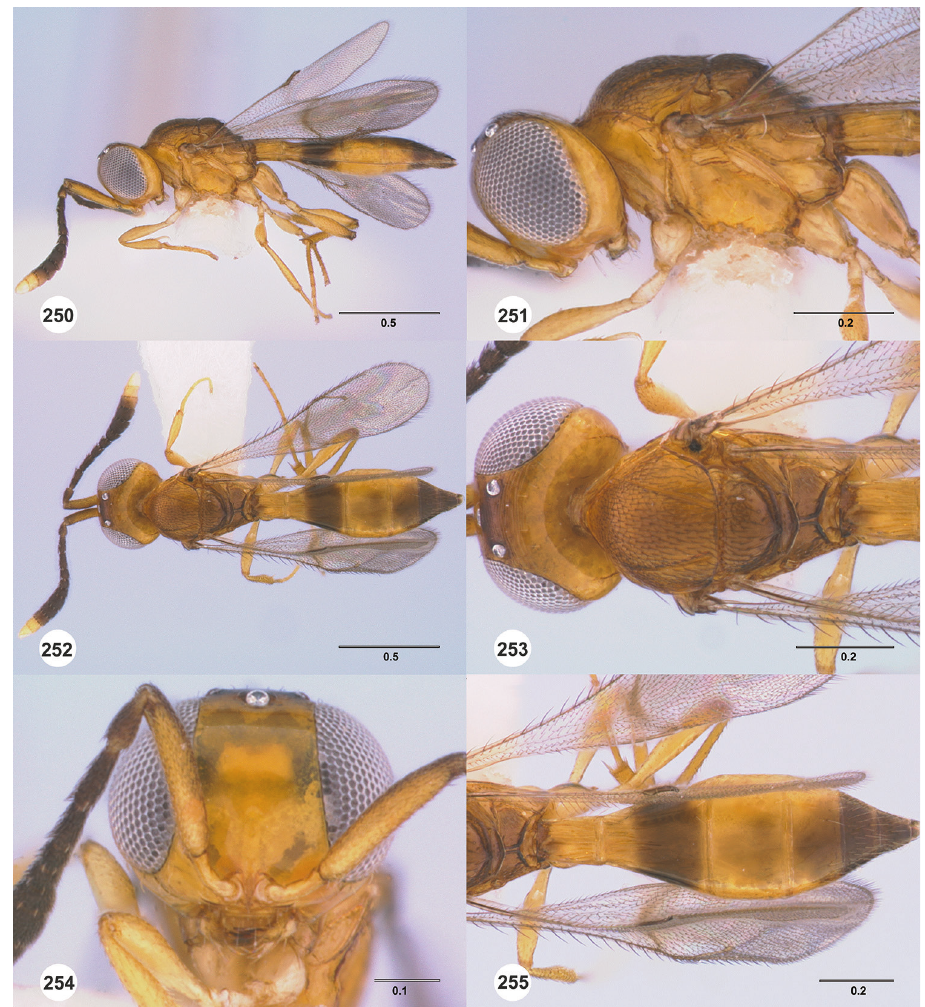
Figures 250–255. Calliscelio suni sp. n., female, holotype (OSUC 182752). 250 Lateral habitus 251 Head and mesosoma, lateral view 252 Dorsal habitus 253 Head and mesosoma, dorsal view 254 Head, anterior view 255 Metasoma, dorsal view. Scale bars in millimeters. propodeum in female: rugose; smooth to rugulose. Sculpture of dorsal propodeum in male: rugose. Median keels on propodeum in female: absent. Mesopleural carina: absent. Sculpture of mesepisternum below mesopleural depression: smooth. Sculpture of ventral metapleural area: largely smooth, rugose ventrally. Color of legs: orange throughout; pale yellow throughout. Sculpture of hind coxa: smooth. Color of fore wing: hyaline. Rs+M: nebulose, weakly pigmented. Setae on R: long, erect, surpassing the margin of the wing. Length of R: distinctly shorter than r-rs. Length of R1: approximately as long as 2.0× length of